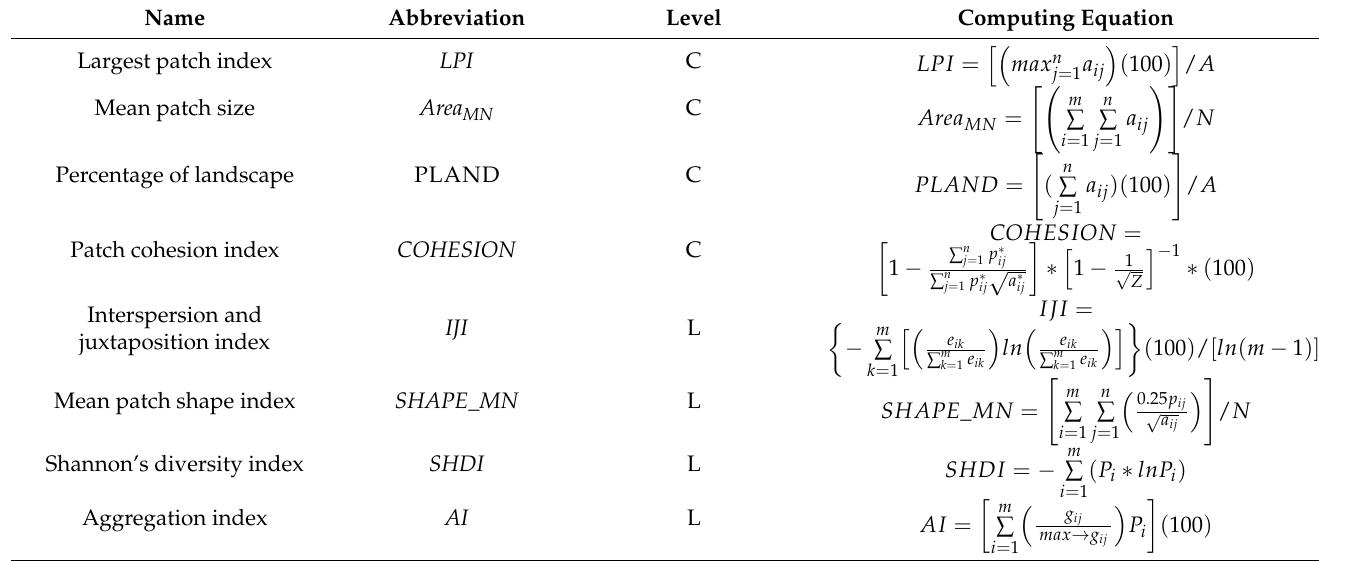
Table 1. Summary information about the landscape indices used in this